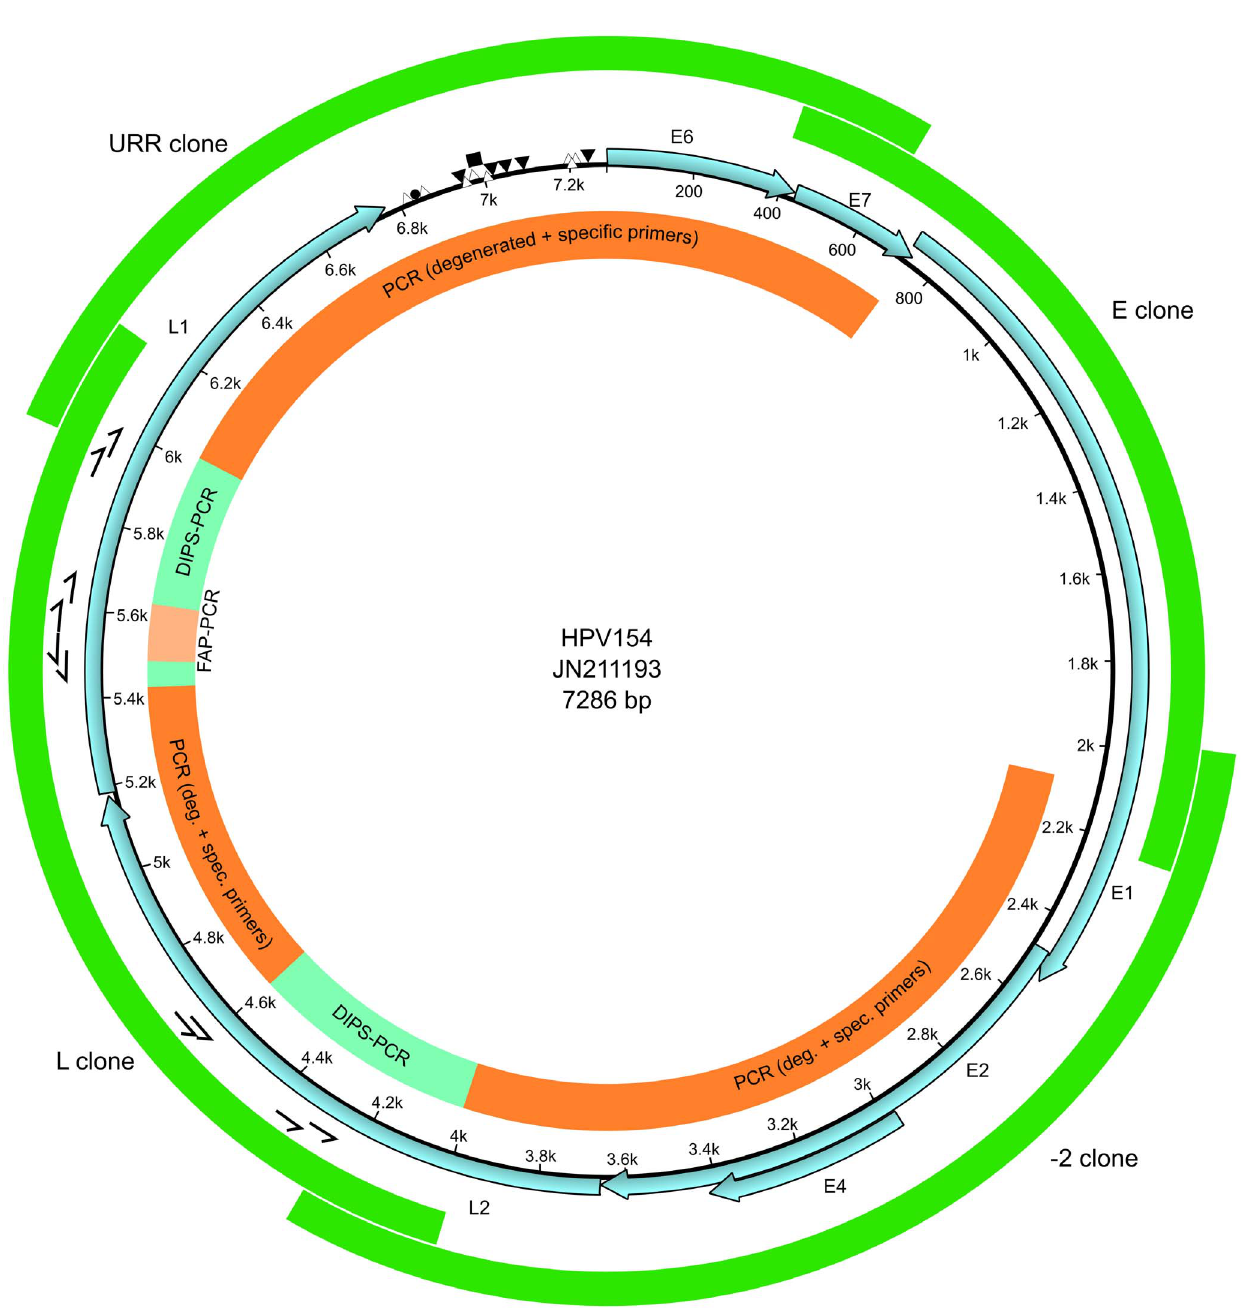
Figure 1. Methodological strategy and genomic organization for HPV154. The ORFs are indicated with light blue arrows. The primers used in the DIPS-PCR are represented with half arrows. The inner circle shows the strategies employed, and the outer circle shows the final clones. Putative N binding sites for viral proteins and cellular factors are shown as follows: E2 binding site, E2BS ( . ); E1 binding site, E1BS ( D ); TATA-box ( & ); ). Polyadenylation signal (